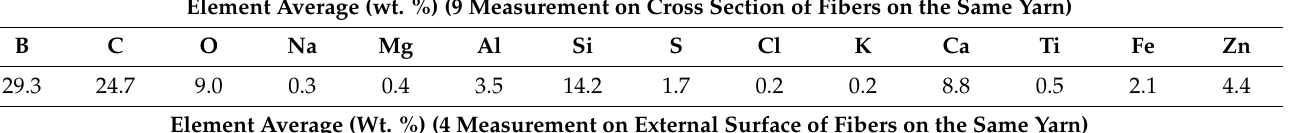
Table 2. Elemental analysis (EDS) of the glass fibers [34].